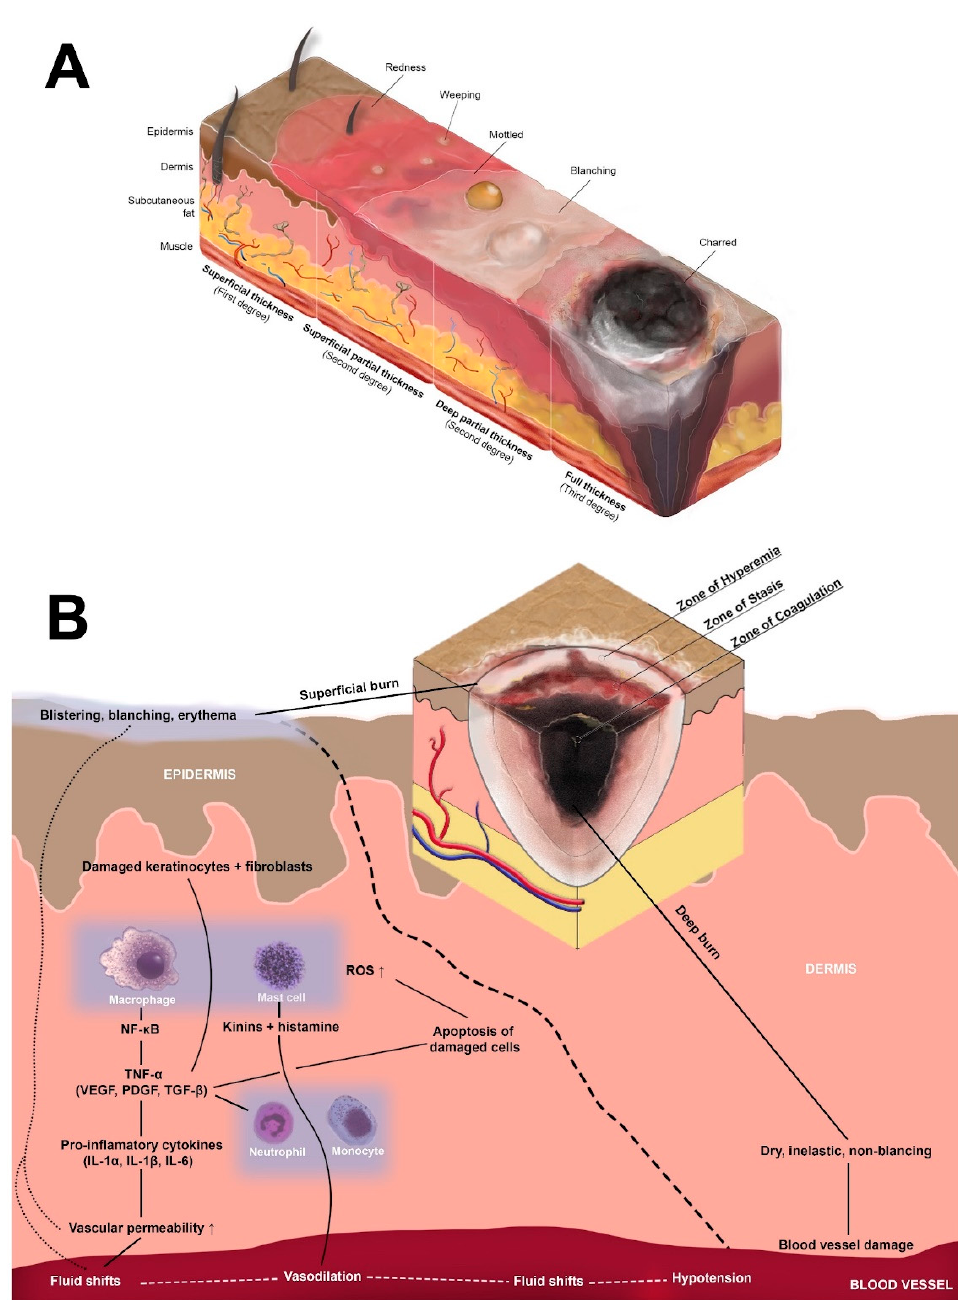
Figure 1. ( A ) Burn depth. Burns are classified as superficial, partial thickness—superficial or deep, or full thickness. Superficial burns damage the different layers of skin, while deep burns damage soft (tissue fat and muscle) and even bone. ( B ) Jackson’s Zones. Burns consist of three distinguished zones of coagulation, stasis and hyperaemia. The zone of coagulation is the innermost zone, the primary site of the injury and once the burn occurs its cells will rapidly undergo necrosis. The surrounding zone of stasis is characterized by tissue damage and ischemia but may still be potentially salvageable. The outermost zone of hyperaemia will usually recover but is characterized by substantial local swelling and redness caused by the immediate inflammatory response to the injury. The innate immune system and its cells are the body’s first line of defense against invading pathogens following burn injury. Characterized by defense against pathogens and disposal of necrotic tissues, the innate immune response paves the way for the proliferative and remodeling phases of wound healing following a burn injury. The picture depicts local inflammatory response to superficial burn in the